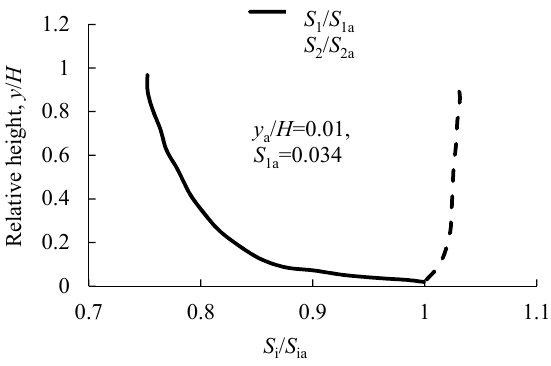
Figure 11. Calculated vertical sediment concentrations comparing with near-bed point concentration (After Zhang and Tan [30]). S i = measured concentration of the vertical profile (kg/m 3 ), and S ia = measured concentration of the near-bed point (kg/m 3 ).